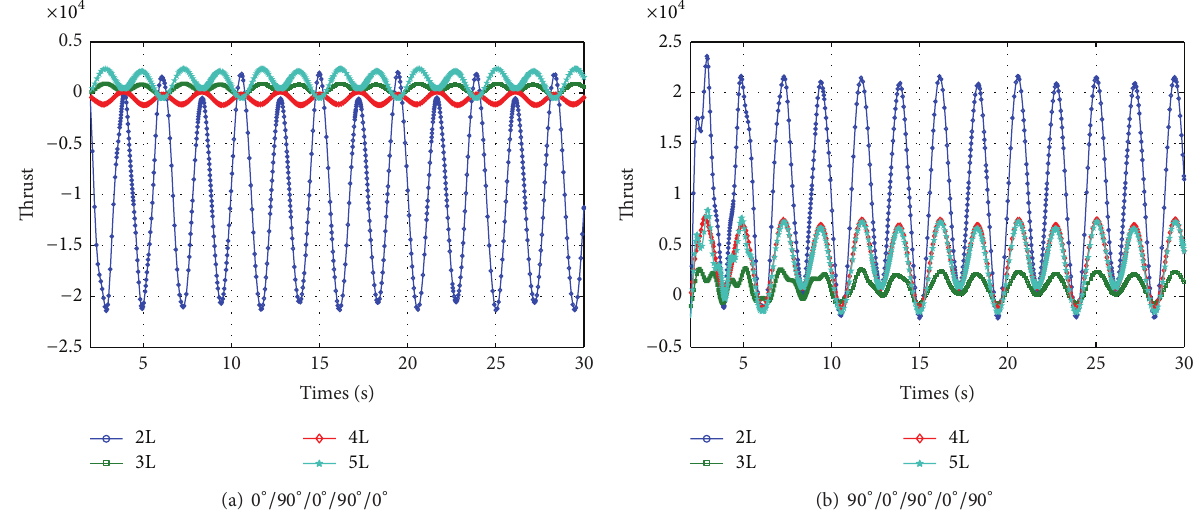
Figure 9: Thrust of fin in the case of combined rotational and translational motion.